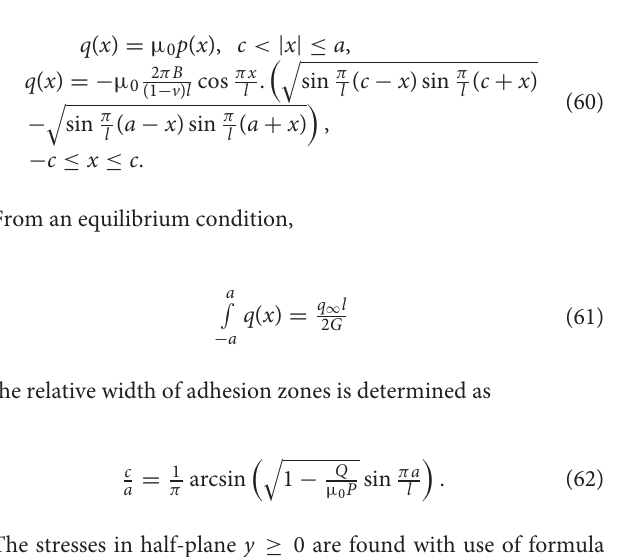
Substituting expressions from Equation (66) into Equation (11), the stresses are determined. In Figure 7 , the distribution of maximum tangential stress τ max ( ν 0.3, l / a 8) is shown in cases ( A ) µ 0 0.25, Q / P = = = = 0.15; ( B ) µ 0 0.5, Q / P 0.3. The solid lines correspond = = to τ max , and the dashed and dash-dotted lines correspond to τ 1 , τ 2 and τ 1 < τ max τ 3 , respectively. The if τ 1 < τ max = = τ 1 reaches the largest value maximum tangential stress τ max = within a half-plane [case ( A )] or at half-plane boundary in points x c [ c / a 0.623 case ( B )]. In the last case, the maximum ± = tangential stress slightly decreases (within 0.6%) along the slip zones. The presented distribution differs a little from the stress distribution in the corresponding cases for a single contact area ( l / a , Contact of Circular Cylinders , Figures 3B , 4A ) and = ∞ coincides with them at l / a ≥